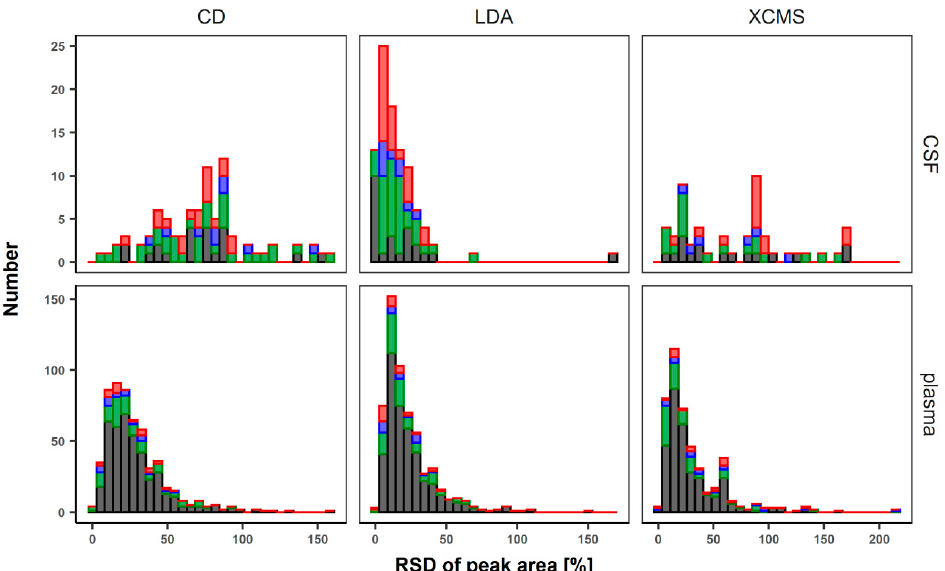
Figure 3. Evaluation of selected and processed data with XCMS online, Compound Discoverer 3.1 (CD) and Lipid Data Analyzer 2.6 (LDA). Relative standard deviations (%RSD) of the peak areas of pooled plasma samples ( n = 5) and pooled CSF samples ( n = 3) are shown as a histogram. The color code indicates the confidence level to which the detected compound belongs: Red: group 1, blue: group 2, green: group 3, and black: group 4 .